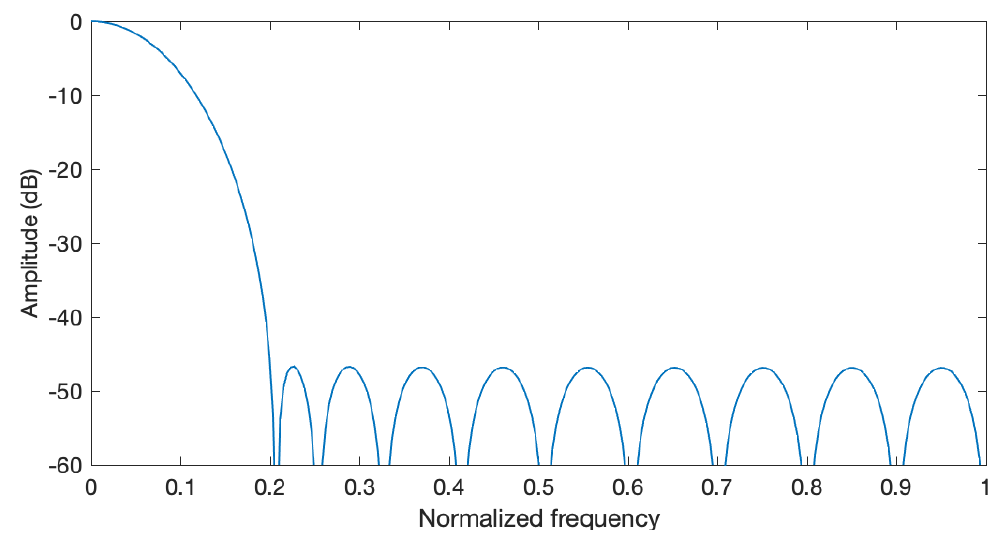
Figure 2. The amplitude response of the designed